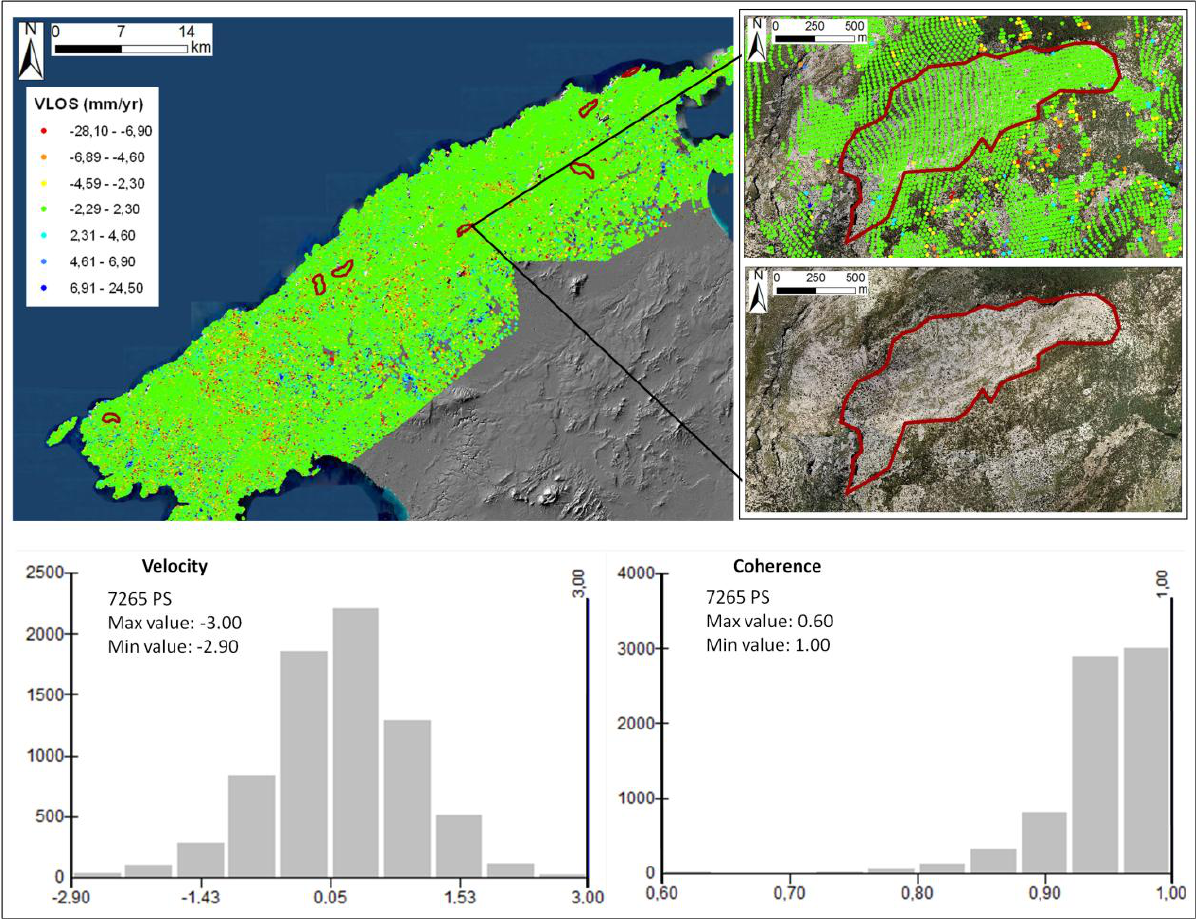
Figure 5. PS Velocity and coherence distribution within some sample rocky outcrops assumed as stable over the Tramuntana range study